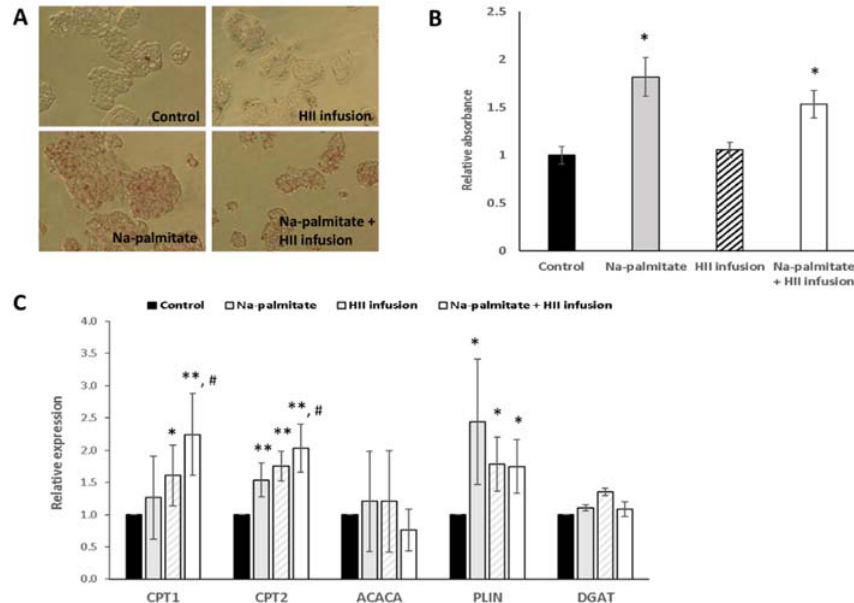
Figure 6. OilRedO staining ( A , B ) and relative gene expression ( C ) in HepG2 cells after the treatment with Na-palmitate, Na-palmitate and HII infusion, and HII infusion compared to control: ( A ) HepG2 cells stained with OilRedO after treatment; ( B ) Relative absorbance (mean ± SD); ( C ) Relative expression (mean ± SD) of different genes (CPT1, CPT2, ACACA, PLIN, DGAT). Asterisk(s) indicate significant differences compared to the control cells with * p < 0.05 and ** p < 0.01. Hashtags indicate significant differences compared to the Na-palmitate-treated cells with # p < 0.05. ACACA—acetyl-